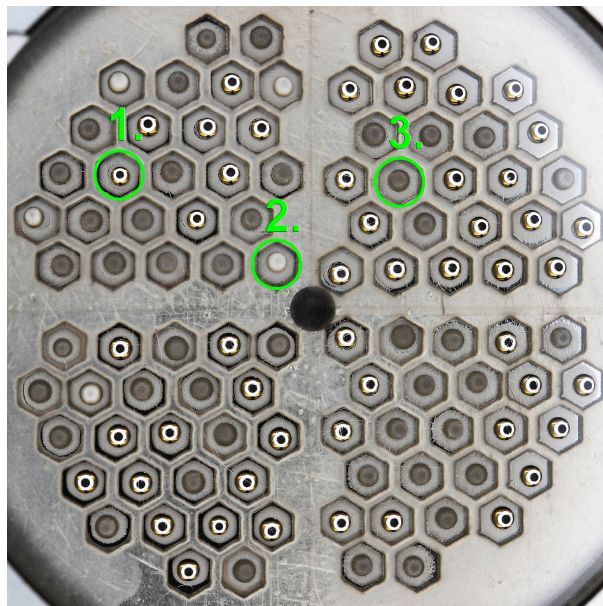
Figure 3. An image generated by LUCS, used as the input data to determine drop-freezing events. The image shows the outlay of the 100 sample drops on the 40 × 40mm stage; each drop is confined to a sealed cell. The image shows drops that are still in the liquid phase and reflect the light from the circular light source (1), drops that are just undergoing freezing (2) and drops that are fully frozen